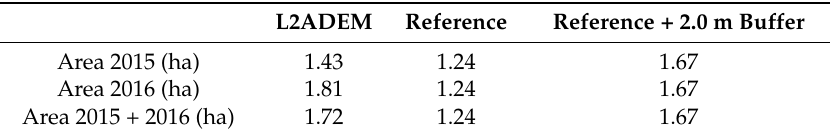
Table 12. Evaluated area from time series on OS2.